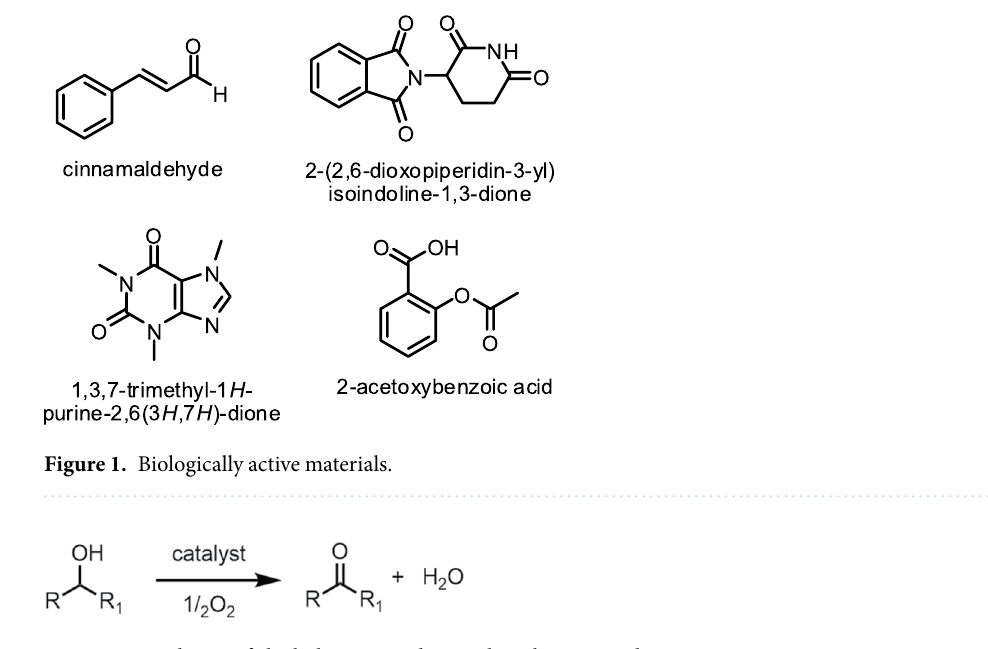
Figure 2. Oxidation of alcohol compounds to carbonyl